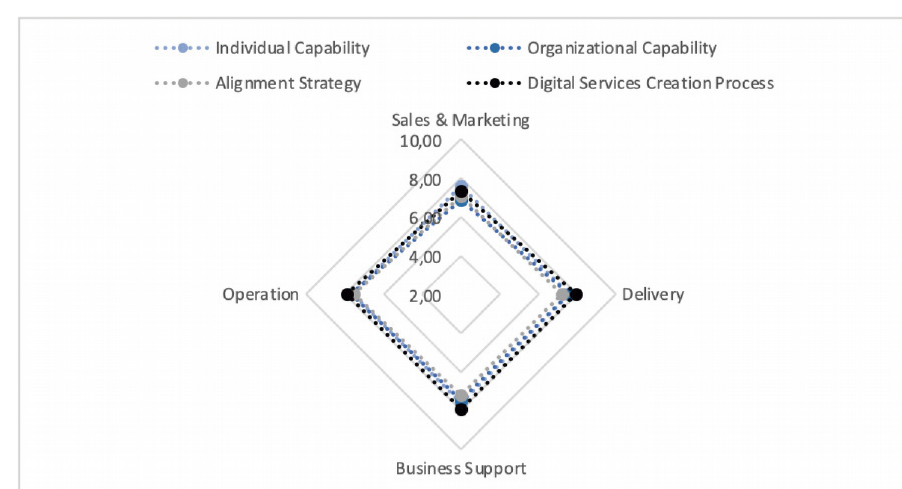
Figure 6. Functional Unit Maturity Mapping on Measured Variables